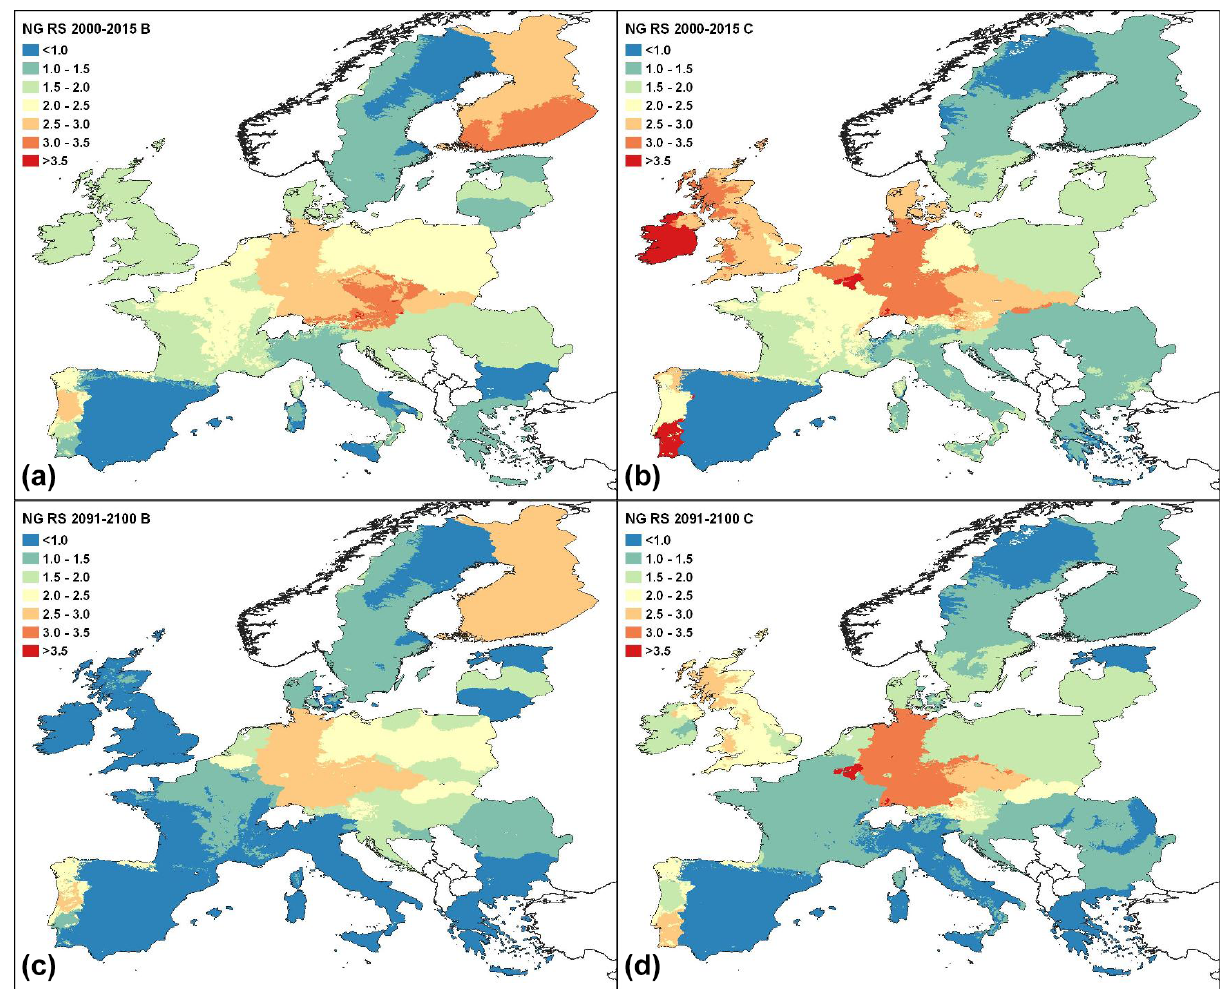
Figure 1. Geographical distribution of the average net growth (NG, in tCha − 1 yr − 1 ) estimated by CBM within the historical period 2000– 2015 (a, b) and within the decade 2091–2100 (c, d) under the RS (i.e. excluding climate change). Broadleaved species are reported on the left side, and conifers are on the right